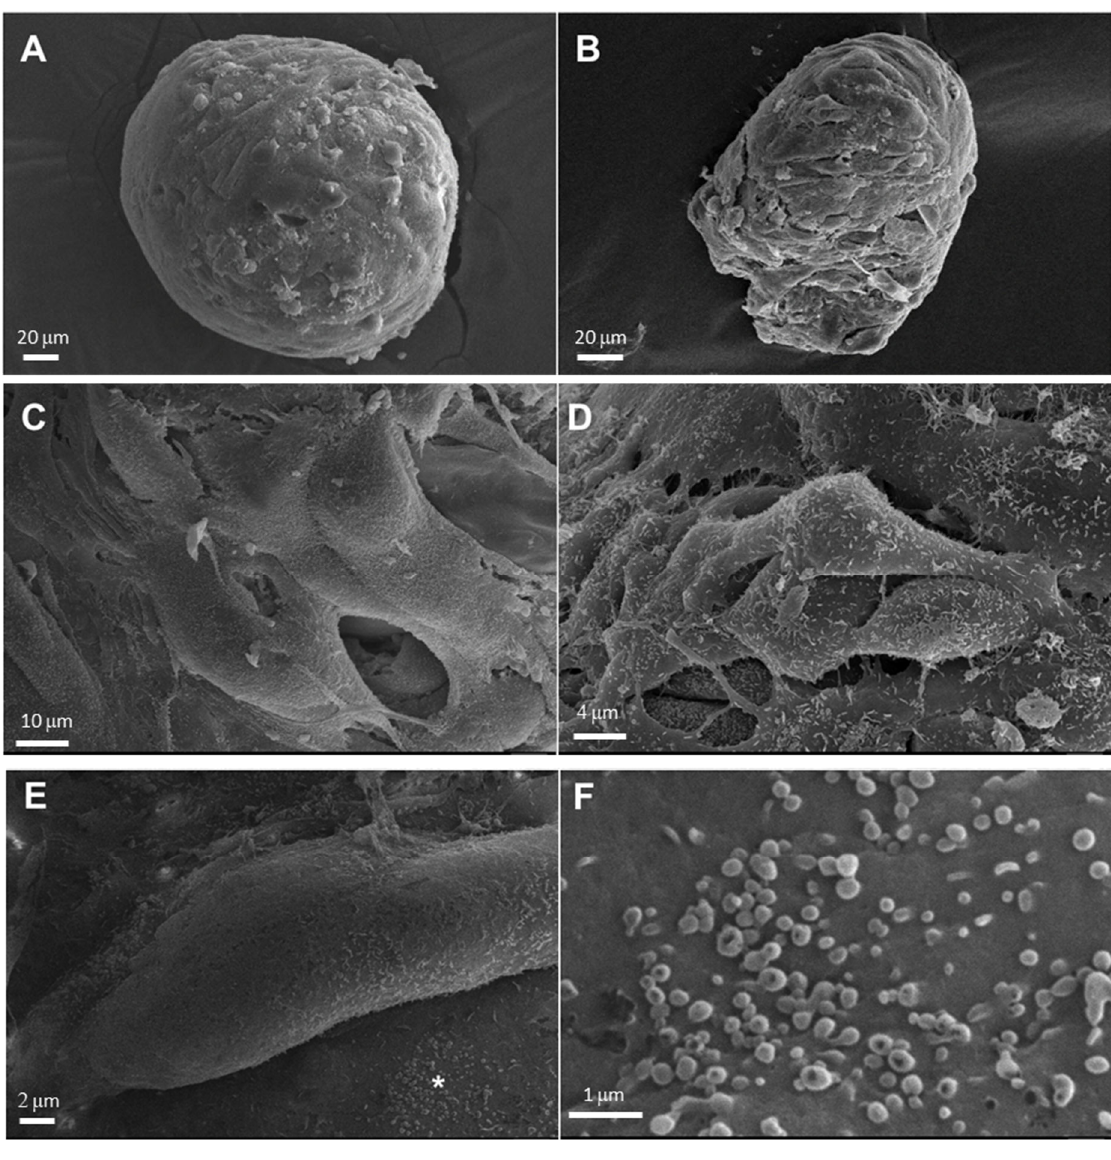
Figure 3. Electron micrographs of MC3T3 ‐ E1 cell spheroids. ( A ) Spheroid on day 0 of treatment with osteogenic medium; ( B ) Spheroid treated with osteogenic medium for 28 days; ( C ) Cells of a spheroid on the day 0 and ( D ) on the 28th day; ( E ) cells aggregated in a spheroid on the 14th day in culture ( F ) enlarged image of the area (*) with possible cell matrix vesicles.